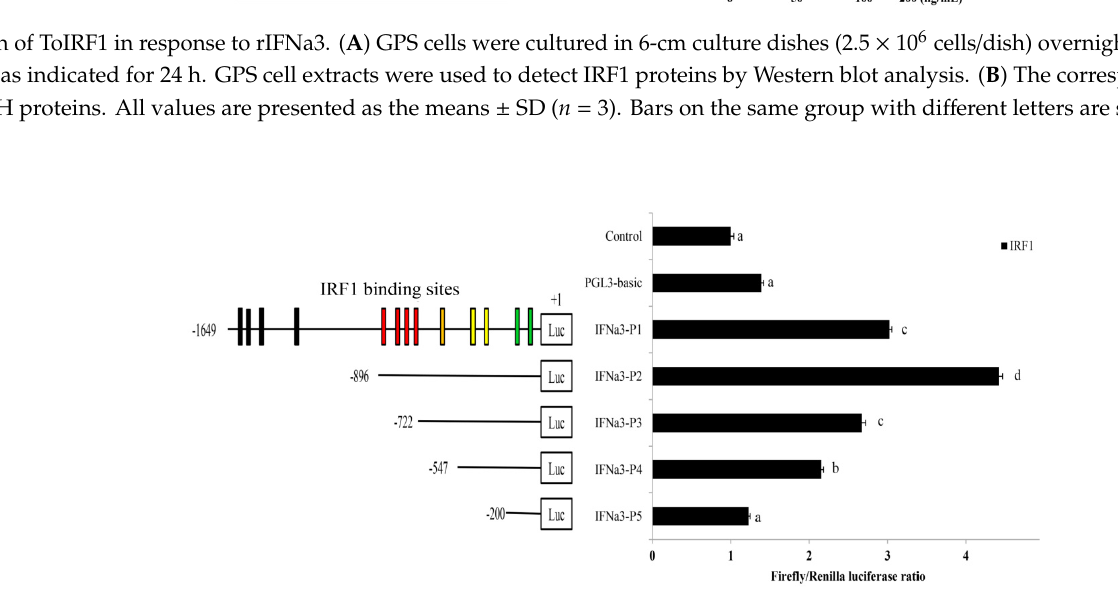
Figure 8. Promoter activity analysis of the ToIFNa3 gene. The structure and transcriptional activity of ToIFNa3 promoters. Five recombinant plasmids were constructed [28,29] and transfected with the transcription factor ToIRF1 into HEK 293T cells. Di ff erent colored boxes indicate ToIRF1 binding sites located in di ff erent truncation regions. All values are presented as the means ± SD ( n = 3). Bars on the same group with di ff erent letters are significantly di ff erent from one another ( p <